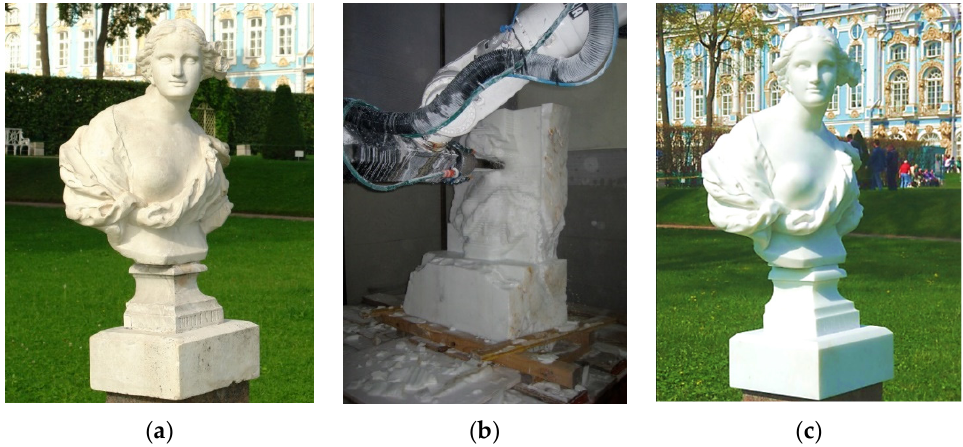
Figure 1. Marble sculpture “Primavera”: general view of original, June 2009 ( a ); process of manu- facturing the replica by CNC machine ( b ); general view of replica, June 2010 ( c ).